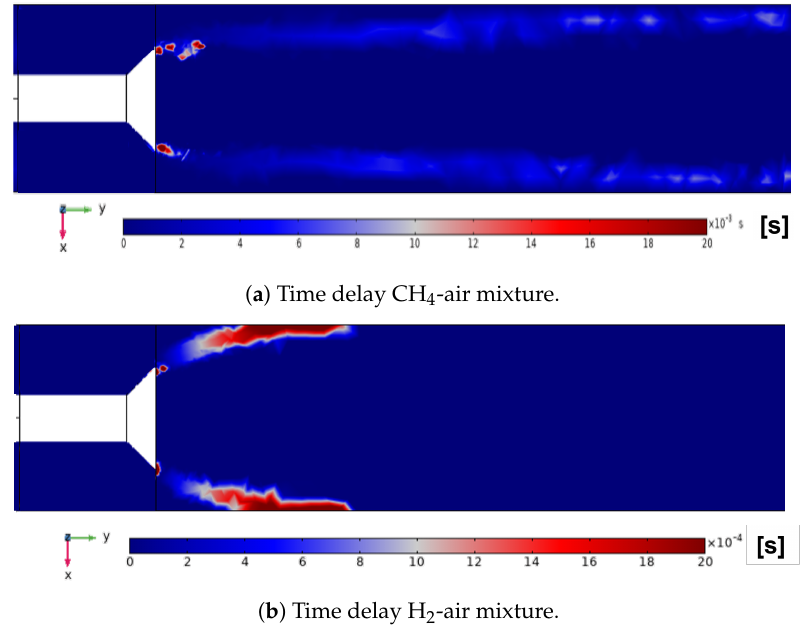
Figure 24. Comparison of the time delay τ for the methane–air and hydrogen–air